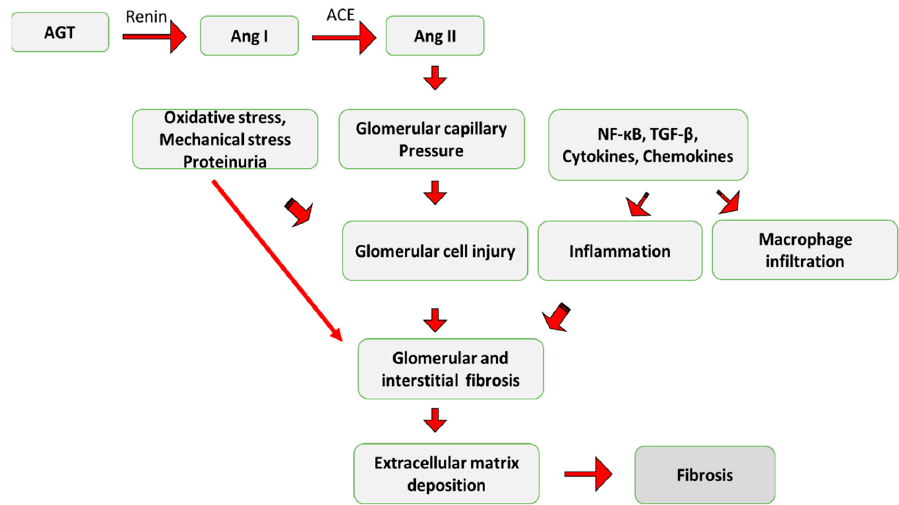
Figure 6. A schematic illustration demonstrates how Angiotensin II (Ang II) contributes to fibrosis. AGT: Angiotensinogen; Ang I: Angiotensin I; ACE: Angiotensin Converting